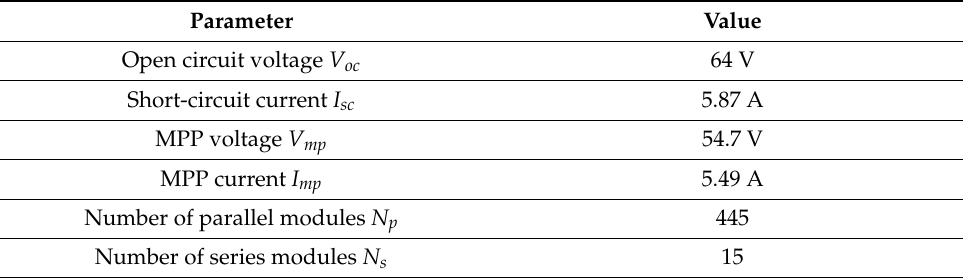
Table 3. PV array